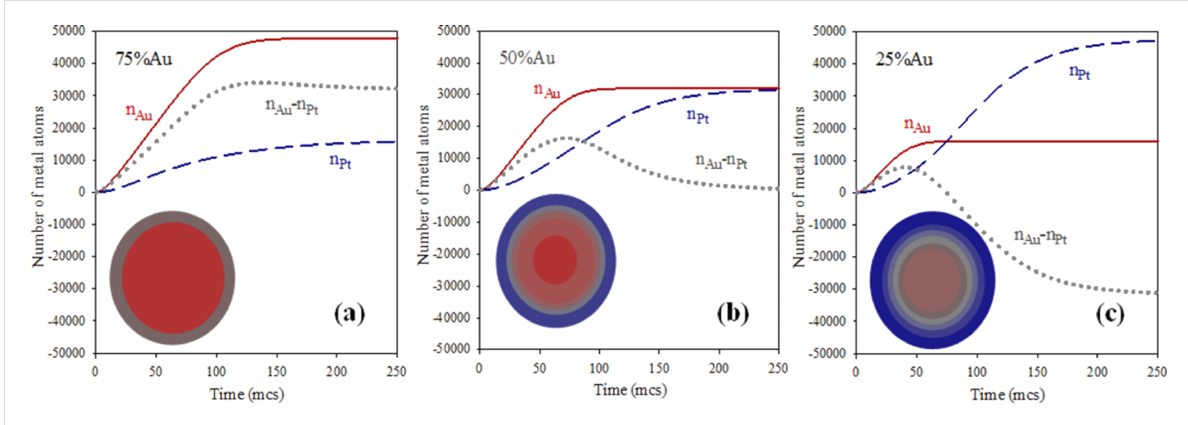
Figure 3: Time evolution of the number of metal atoms obtained in micelles. Continuous and discontinuous lines show the resulting Au and Pt, res- pectively. Dotted lines represent the difference between the number of Au and Pt atoms. Synthesis conditions: flexible film ( k ex = 5, f = 30), reduction rate ratio v Au /v Pt = 10, average concentration = 64. a) 75% Au, = 96, = 32; b) 50% Au, = 64, = 64; c) 25% Au, = 32, =